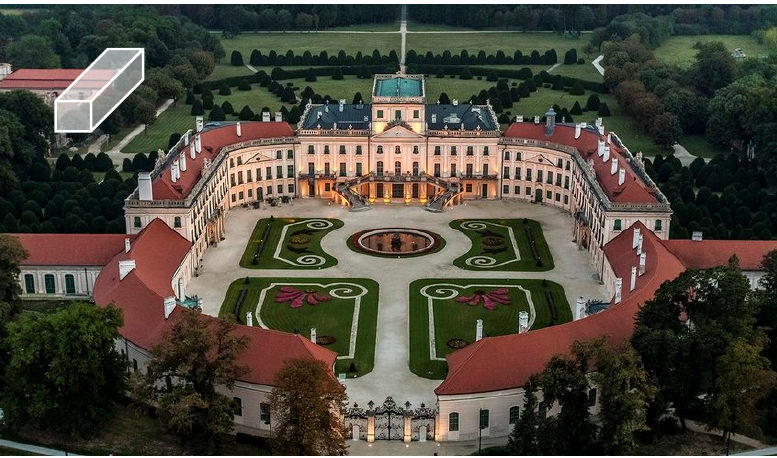
Figure 4. View of restored Esterházy Palace [16]. The position of the Eszterháza Opera House is indicated with the white box.